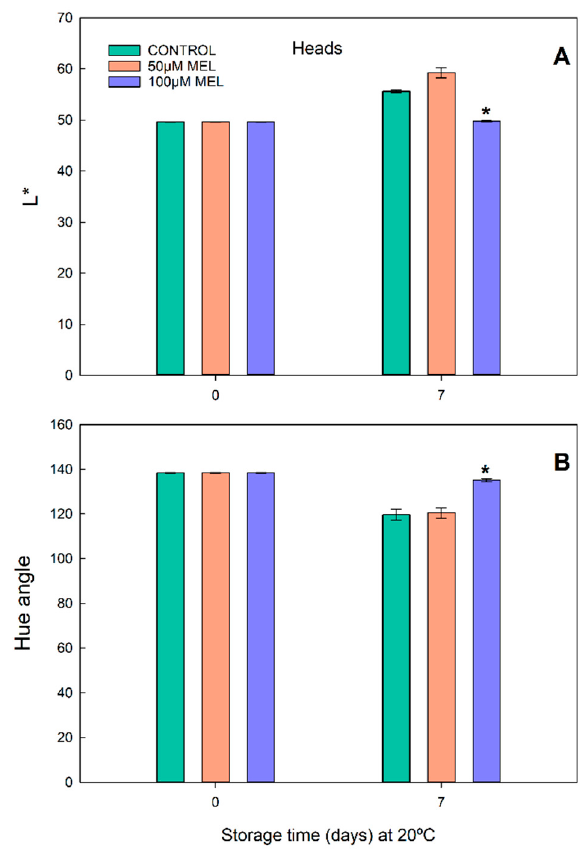
Figure 2. Color parameters in broccoli heads stored at 20 °C. ( A ) Luminosity (L*) and ( B ) Hue angle of broccoli heads treated with 50 and 100 μ M of melatonin and stored in the dark at 20 °C for 0 and 7 days. Each bar represents the mean value ± standard error ( n = 3) obtained for each concentration used. Asterisks indicate significant differences with the control of that day based on a Tukey HSD test with a significance level of p < 0.05.